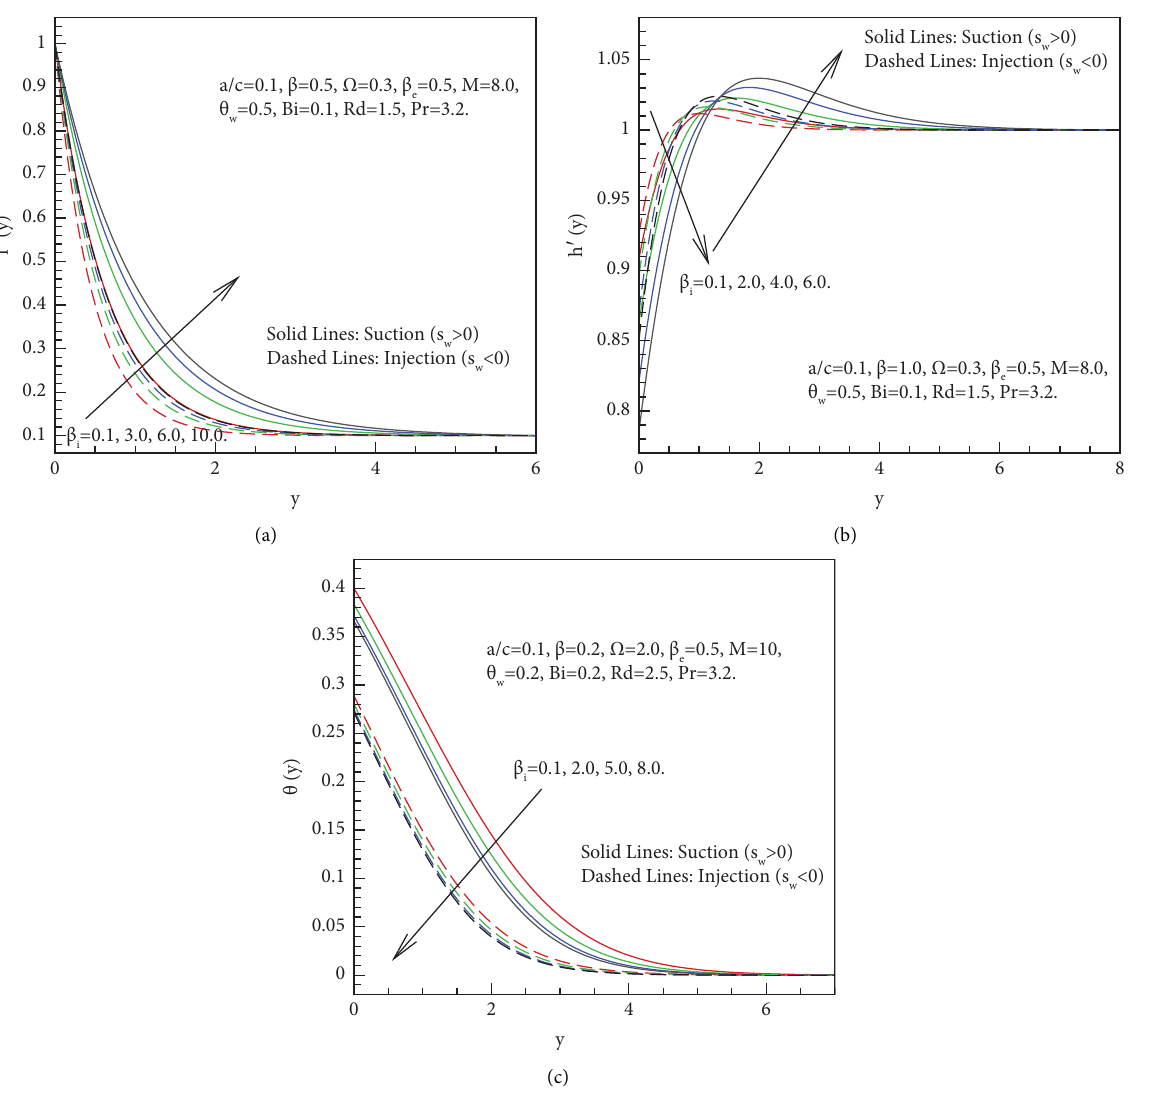
Figure 3: (a) Velocity distribution f ′ ( y ) , (b) velocity distribution h ′ ( y ) , and (c) temperature distribution θ ( y ) for ion slip parameter β